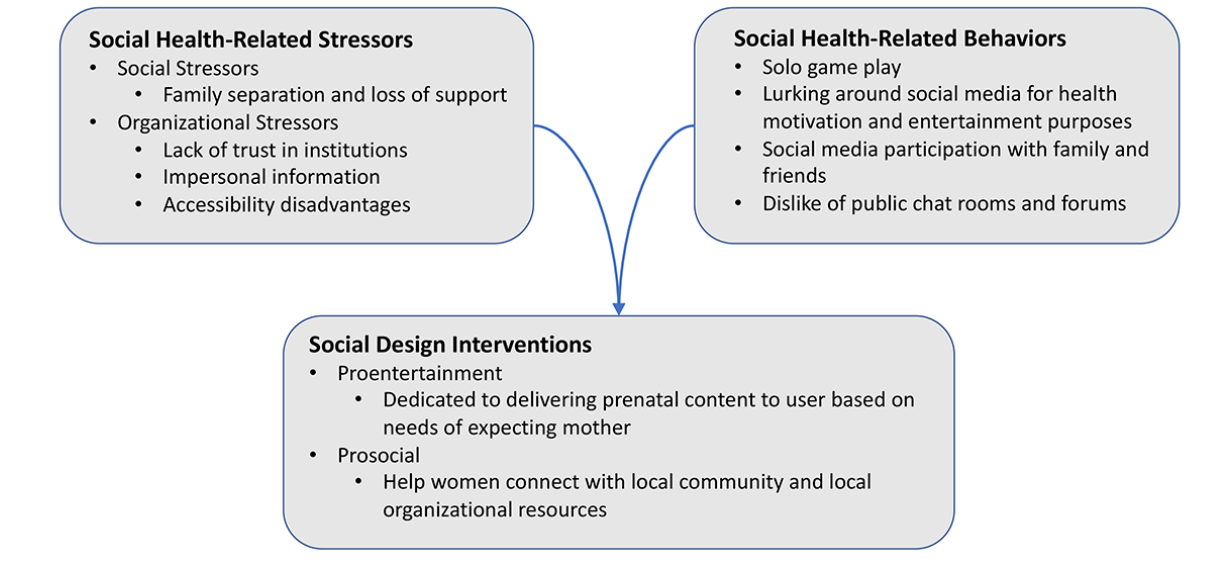
Figure 1. Themes related to social health-related stressors, social health-related behaviors, and social design